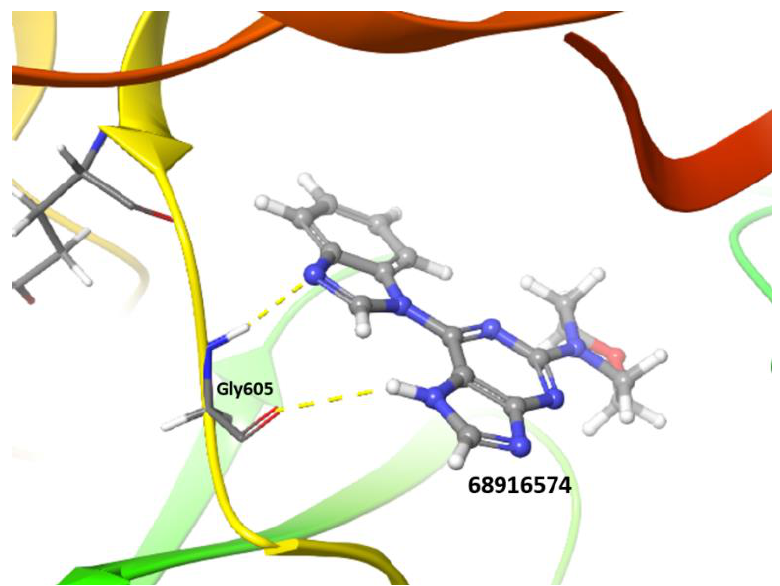
Figure 3. Cartoon showing the structure of the Mps1 kinase – 68916574 small compound complex. The latter molecule is shown in grey (XP GScore −9.3 kcal/mol). H -bond interactions between 68916574 and the Mps1 residue Gly605 are shown in yellow dashed lines.